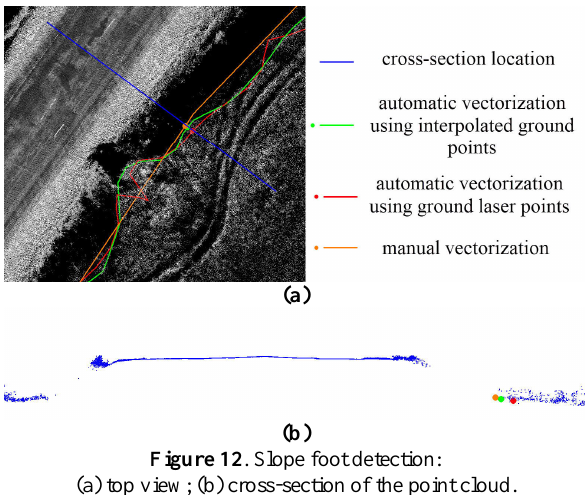
Figure 12 . Slope foot detection: (a) top view; (b) cross-section of the point